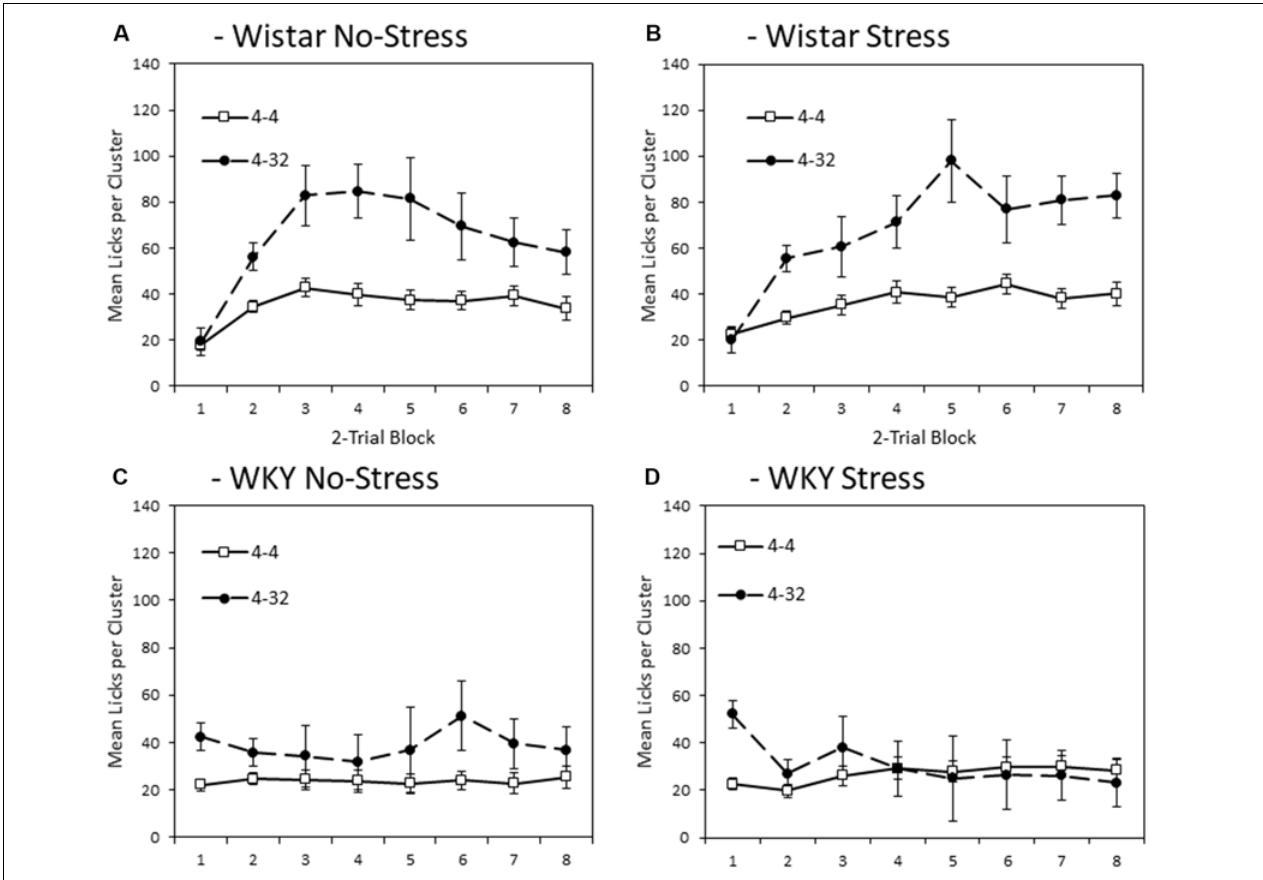
FIGURE 5 | Mean lick cluster size (LCS: ± SEM) for the second solution available each day (4% vs. 32% sucrose) separated by strain (Wistar: Panels A,B ; WKY: Panels C,D ) and stress groups (No-Stress: Panels A,C ; Stress: Panels B,D ). Open symbols represent responses to the 4% sucrose solution, the filled symbols represent responses to the 32% sucrose solution made available in the second bottle. Data presented is averaged across 2-session blocks. While both WKY and Wistar rats showed significantly higher lick cluster size for 32% than 4% sucrose (reflecting its higher palatability), this difference was significantly smaller in WKY rats and mean lick cluster size overall was significantly lower in WKY rats, indicating a blunted hedonic response (see “Second Solution Lick Cluster Size—Low vs. High Sucrose Concentration” section for